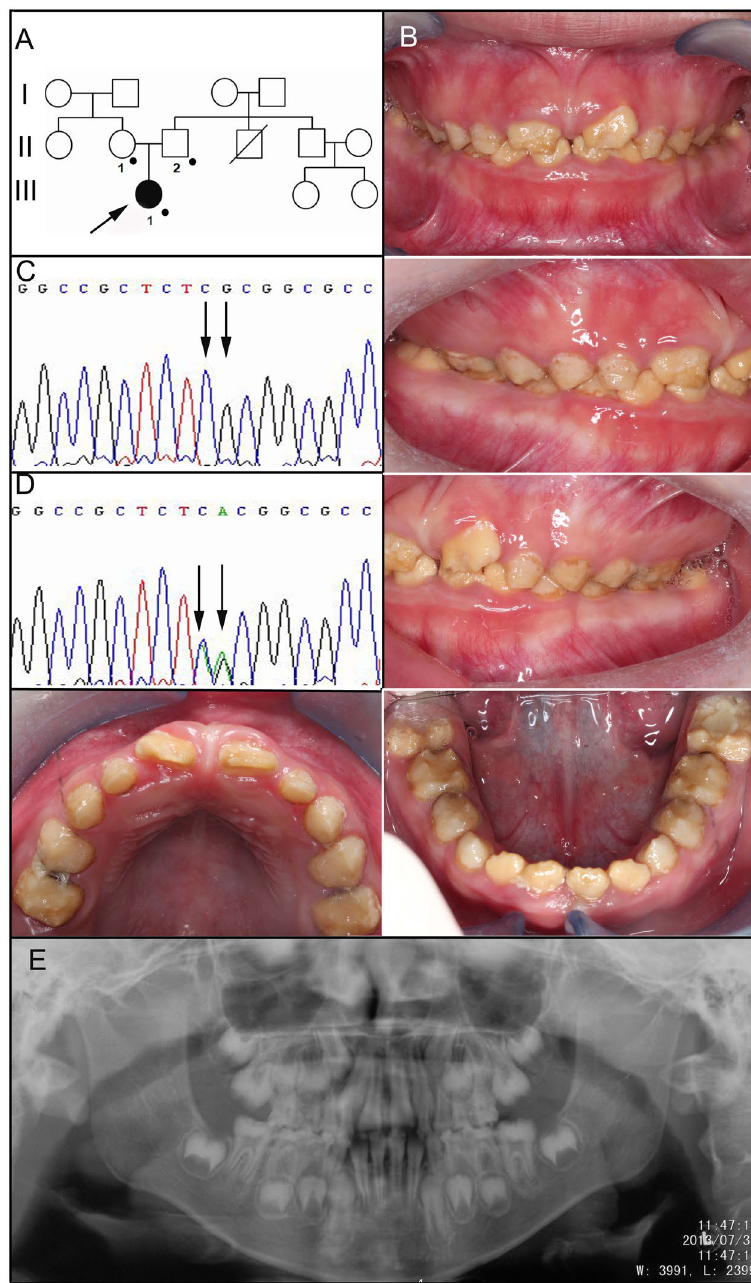
Figure 2. Clinical and mutational analysis of Family 2. ( A ) Pedigree of Family 2, Proband (III:1). Black dots indicate members recruited for this study. ( B ) Oral photographs showing enamel malformations categorized as hypocalcified AI. ( C , D ) FAM83H exon 5 sequencing chromatogram of an unaffected family member (II:1) ( C ), and the proband (III:1) ( D ), revealing a novel nonsense mutation: c.1130_1131delinsAA, p.S377X. ( E ) Panoramic radiograph of the proband taken at the age of